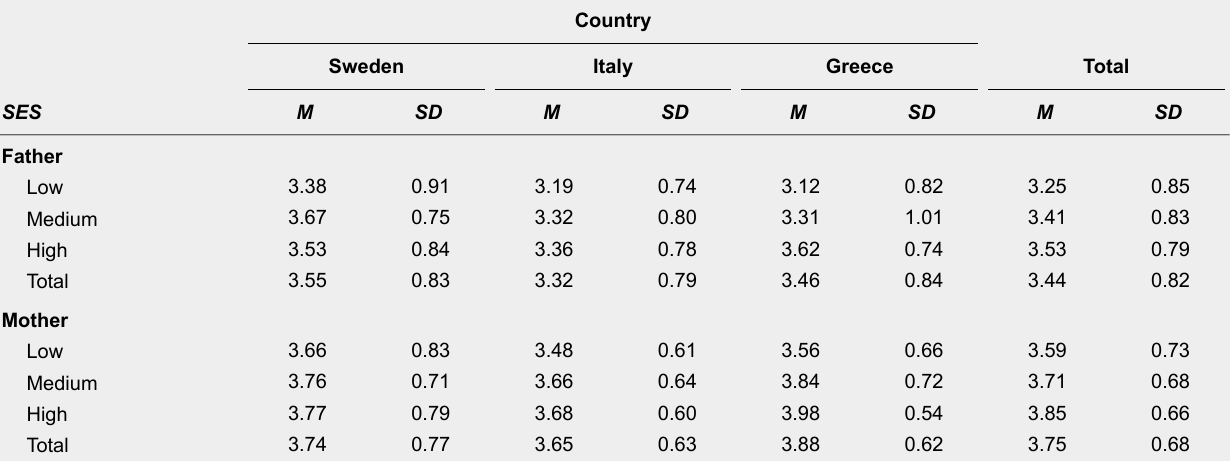
PermissiveAuthoritarian